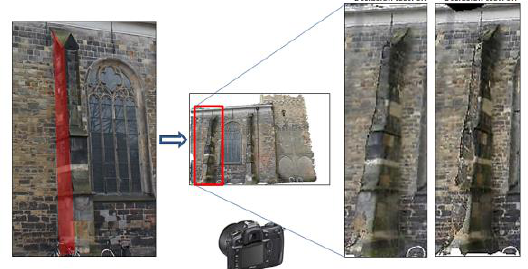
Figure 15. Self-occlusion in synthetic image with and without visibility test